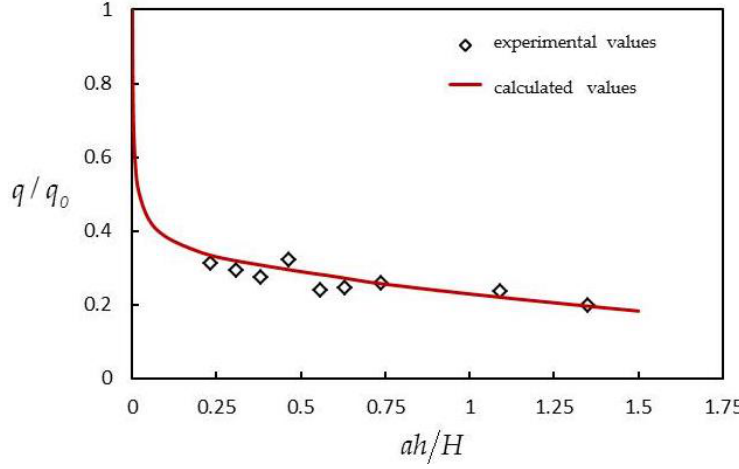
Figure 8. Ratio of single-width-discharges q/q 0 varies with the comprehensive parameter ah/H .